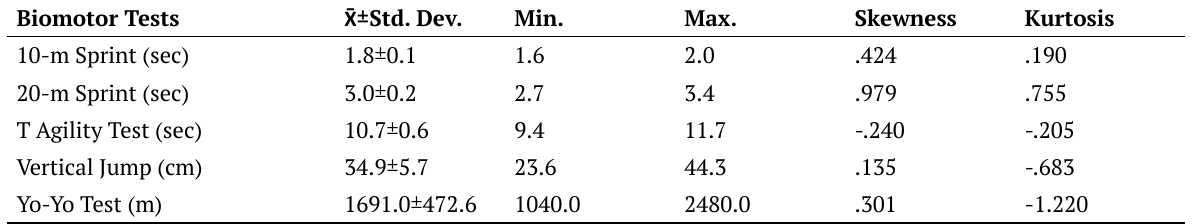
Table 2. Descriptive Statistics Results for Biomotor Tests